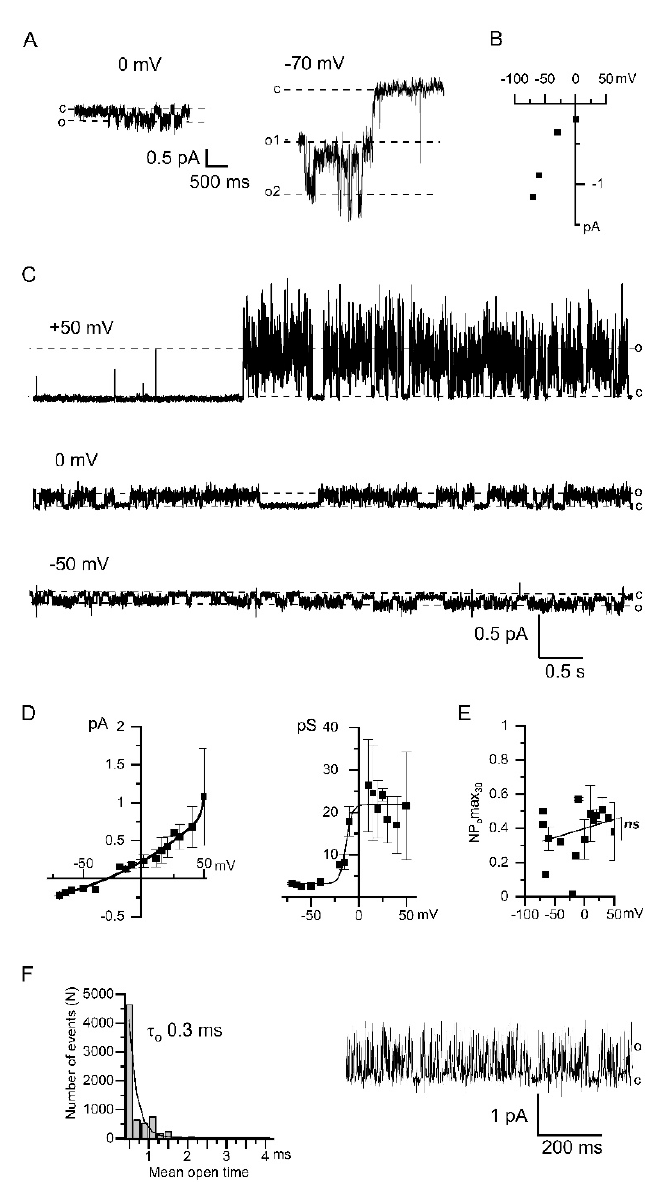
Figure 4. Properties of Ca 2+ -activated chloride channels upon using fast Ca 2+ chelator 10 mM BAPTA. ( A ) Examples of single channel recordings through the TRPC1 channels induced by the bath application of 2.5 µ M IP 3 in inside-out patches. Membrane potentials were held at 0 mV (left) and − 70 mV (right). ( B ) Current–voltage relationship of store-operated TRPC1 channels is induced by 2.5 µ M IP 3 application. Approximation of conductance gives 21 pS ( n = 3–7). ( C ) Current recordings of CaCCs-activated following IP 3 -induced Ca 2+ entry registered at different membrane potentials +50 mV, 0 mV, − 50 mV (top to bottom). ( D ) Left : The current–voltage relationship of CaCCs in the BAPTA containing bath solution ( n = 4–8). Right : The dependence of the CaCC conductance on the membrane potential ( n = 4–8). ( E ) The dependence of the CaCC activity, expressed as NPomax30, on the membrane potential ( n = 4). ( F ) Histogram of the open state lifetime distribution of the CaCCs. The membrane potential is +30 mV. An exponential fit gives an average lifetime of 0.3 ± 0.1 ms. The total number of events is n = 7946. Typical fragment of the current used for the histogram, monitored at +30 mV and filtered at 1 kHz.